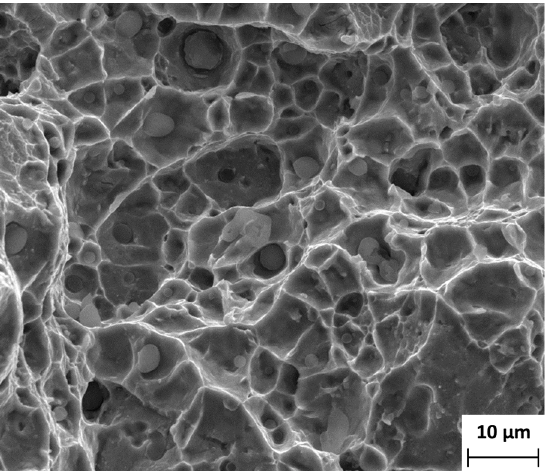
Figure 8. SEM micrograph of a typical crept fracture surface (D1 material, tested at 550 MPa).